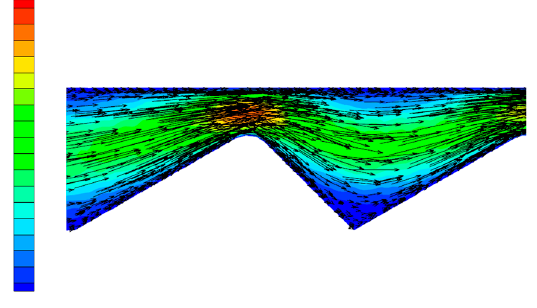
Figure 6. Laminar flow vectorgraph. Polymers 2019 , 11 , x FOR PEER REVIEW